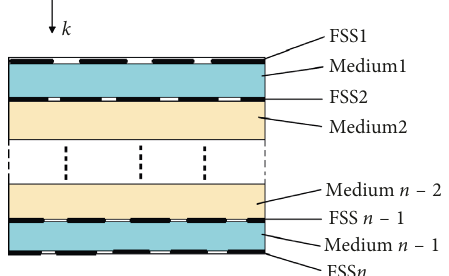
Figure 2: Structure of multilayer